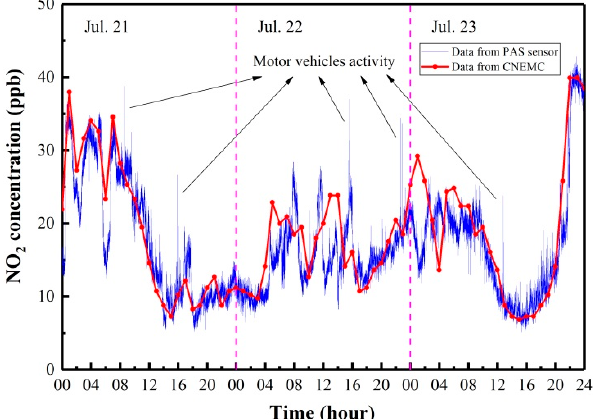
Figure 8 . Continuous three-day monitoring of environmental NO 2 concentrations measured in July 2019 on the Shanxi University campus, China (blue) and corresponding data available from a nearby station of the China National Environmental Monitoring Center (red).